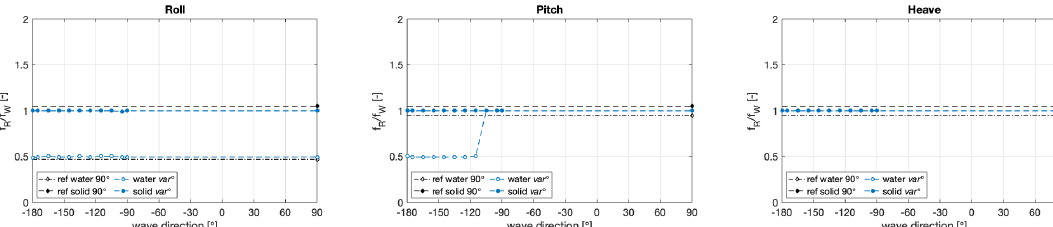
Figure 17. Frequency response f R normalised by the wave frequency f W in addition to Figure 16—the reference values (either 0.5 or 1[-]) are multiplied by a factor to make them better visible—water (cid:109) and solid (cid:108) ballast